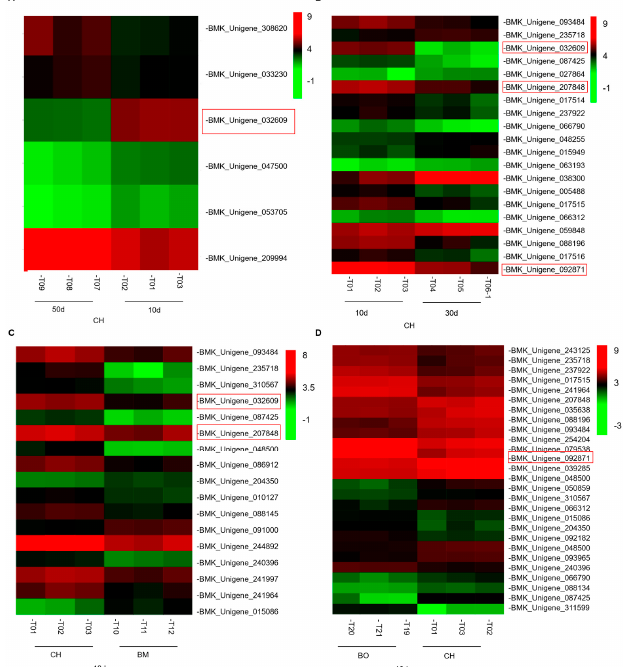
Figure 6. Heatmap showing anthocyanin metabolic signaling associated unigenes that were differentially expressed between 50-day and 10-day leaves of CH ( A ), between 30-day and 10-day leaves of CH ( B ), between 10-day leaves of BM and CH ( C ), and between 10-day leaves of BO and CH ( D ). Red frames show the unigenes of UFGT and ANS .